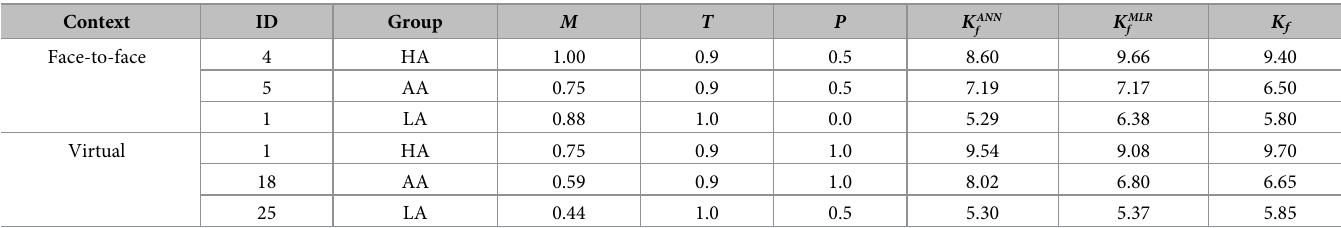
Table 3. Excerpt from the data with the surveys